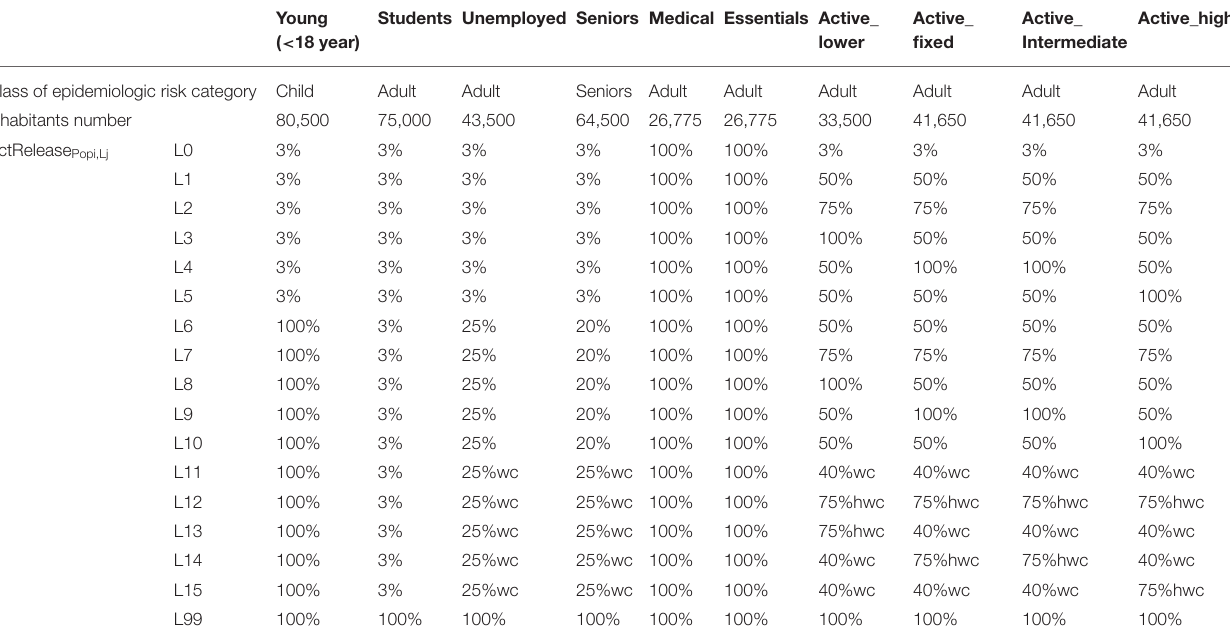
TABLE 1 | Description of the socio-professional categories and the lockdown exit